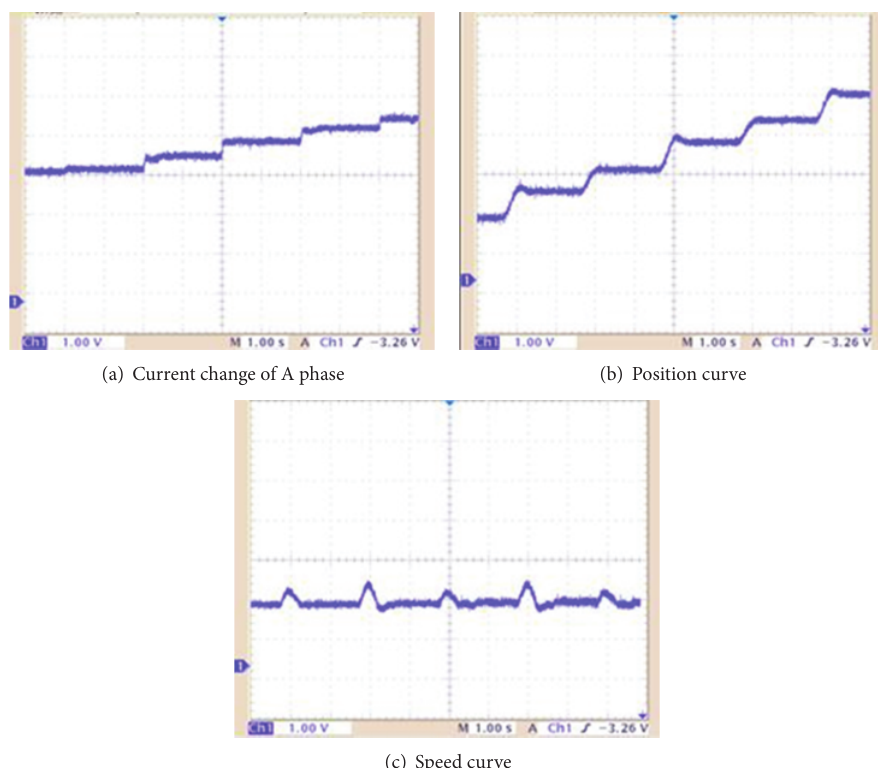
Figure 15: Experiment curve of constant frequency control.